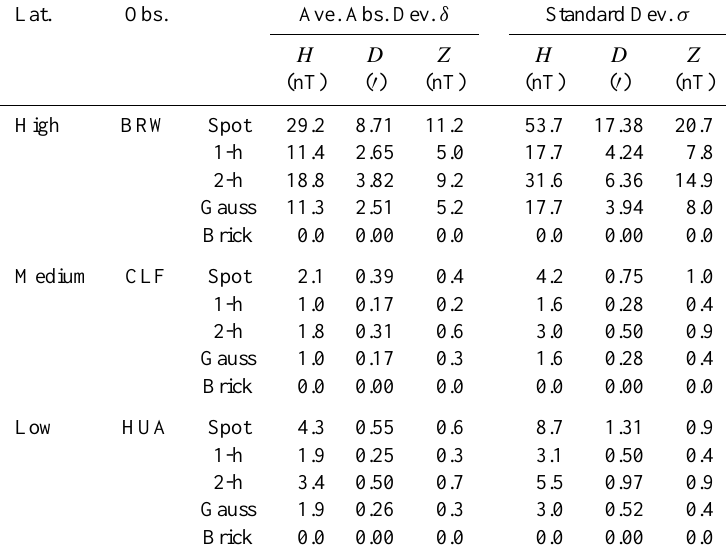
Table 3. Statistics of low-frequency residuals L as (t) for 1998.0–2009.0. Lat. Obs.